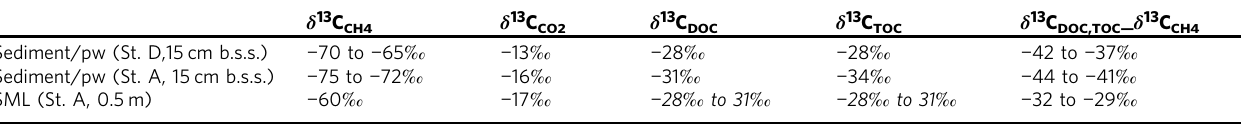
Table 3 Evaluation of stable carbon isotope fractionation in porewater and surface water δ 13 C CH4 Sediment/pw (St. D,15 cm b.s.s.) Sediment/pw (St. A, 15 cm b.s.s.) Stable carbon isotope ratio of CH 4 ( δ 13 C CH4 ) and its possible carbon precursors (TOC, DOC) measured in Lake Hallwil sediment and porewater (pw) at St. D (2.5m deep) and St. A (45m deep) and surface mixed layer (SML, St. A, lake center). Measurements refer to June – August 2015. Values in italics are assumed from literature 68 (see Supplementary Fig. 1 for stations map)